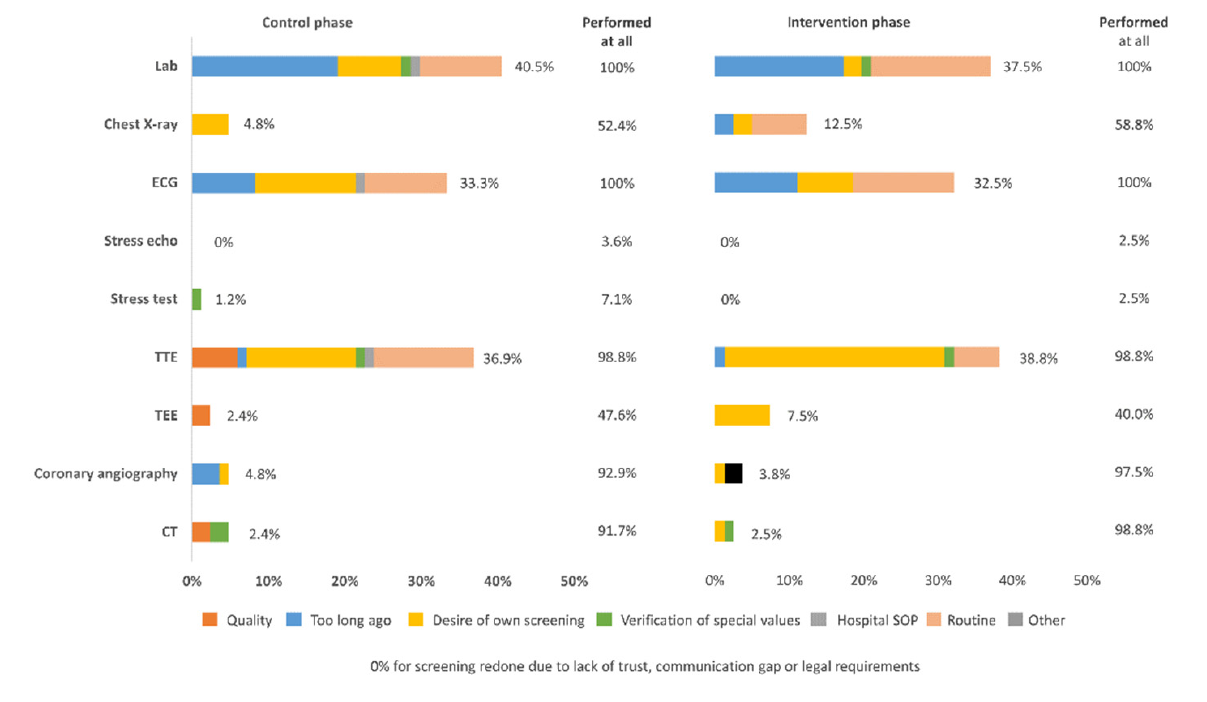
Figure 2. Screening procedures that were repeated, with given reason, for the control vs. intervention phases. CT, computed tomography; ECG, electrocardiogram; SOP, standard operating procedure; TEE, transesophageal echocardiogram; TTE, transthoracic echocardiogram.